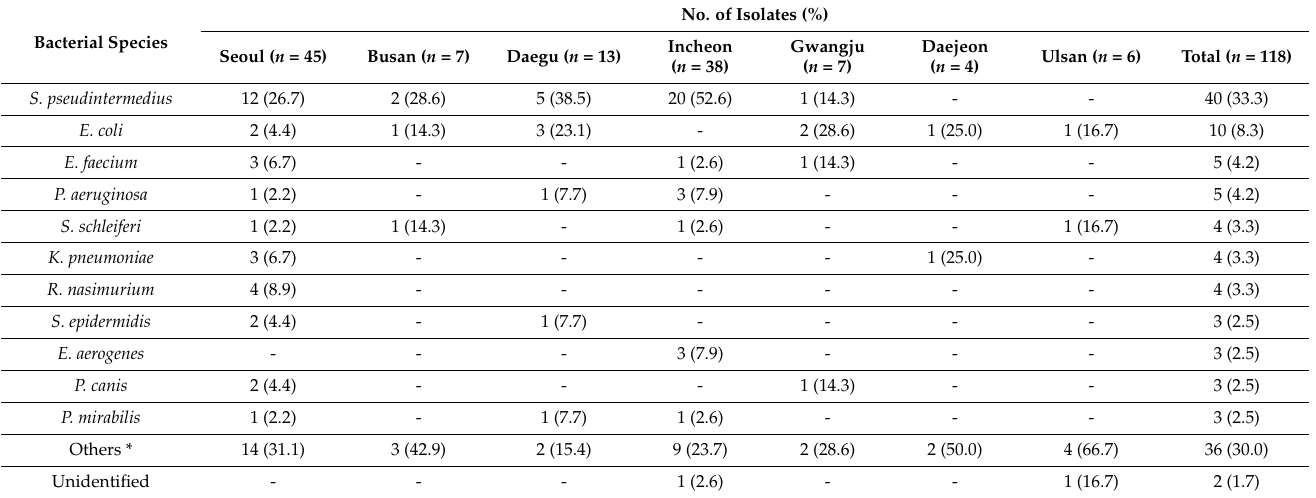
Table 5. Recovered isolate prevalence in respiratory samples of dogs during nationwide surveillance